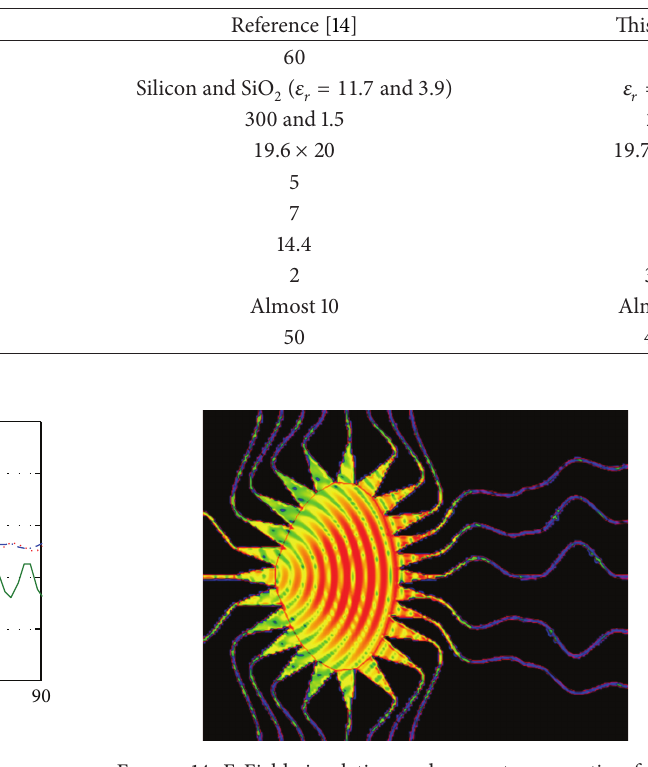
Figure 14: E-Field simulation and current propagating for beam port number two